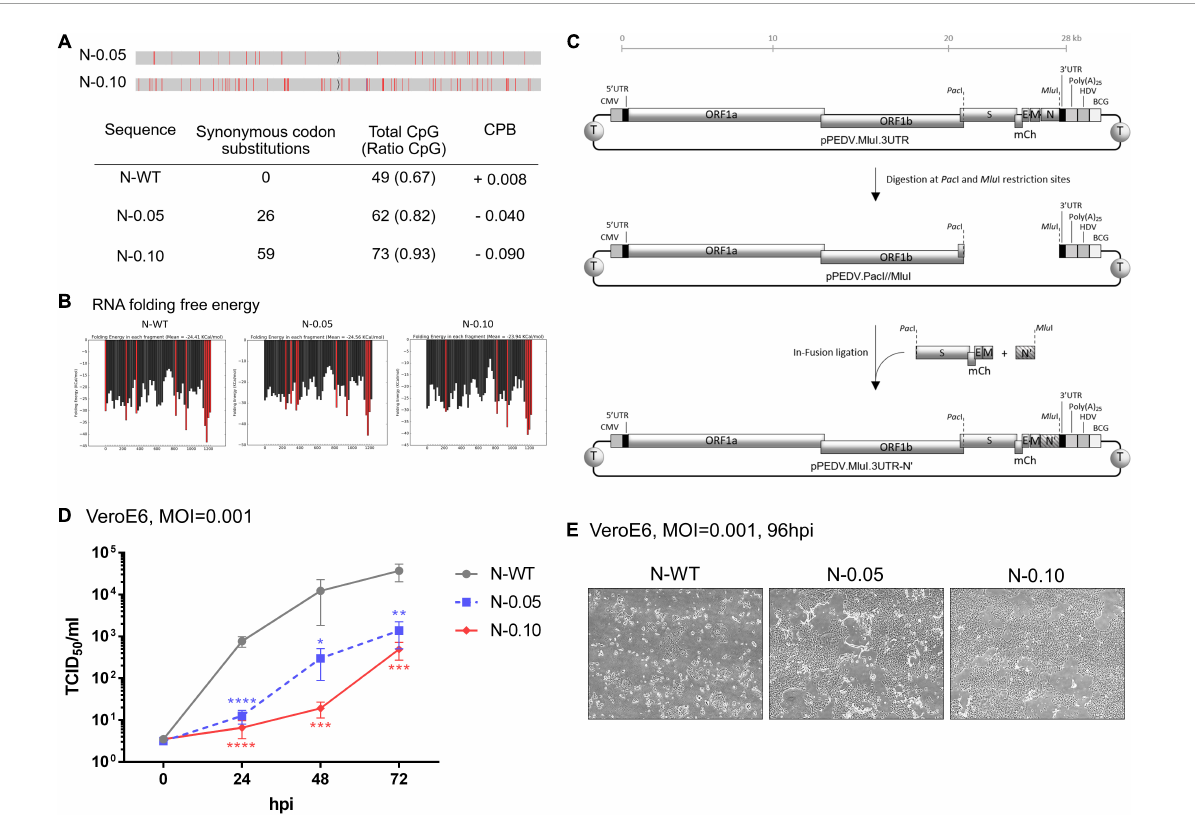
FIGURE3 Increasing CpG content in the N gene results in slower growth of porcine epidemic diarrhea virus (PEDV) in VeroE6 cells. (A) Analysis of generated nucleotide sequences encoding PEDV-N protein with varied CpG dinucleotides. Red lines in a sequence bar display silent mutations where the original nucleotides are replaced to increase CpG content. Synonymous codon substitutions, CpG dinucleotide compositions, and codon-paired bias (CPB) values of each sequence are listed in the Table. (B) RNA folding free energy profiles for each 100- and 20-base window of the generated CPD-N sequences compared to the native N gene sequence. The red bars indicate the high ( < –30 Kcal/mol) free energy of RNA folding. (C) Construction of infectious clones using the N genes with high CpG content. PCR-amplified products of an oligonucleotide fragment from the S gene to the M gene (S-mCherry-E-M) and another fragment of various N genes (N (cid:48) ) were inserted into a pre-cut vector containing the rest of the viral genes (pPEDV.mCh. Mlu I.3UTR) by the In-Fusion ligation method. (D) VeroE6 cells were infected with each recombinant PEDV (MOI = 0.001) and virus replication was monitored at the indicated time points by the TCID 50 assay. Values shown are averages ± SEM of three independent experiments. (E) Representative images of virus spread in the infected cells at 96 hpi are